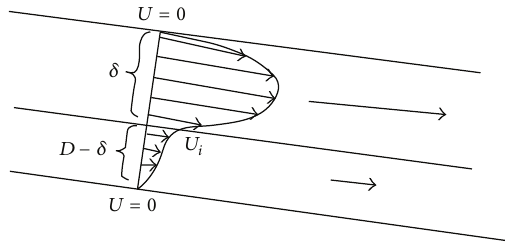
Figure 1: Lateral view of stratified flow.